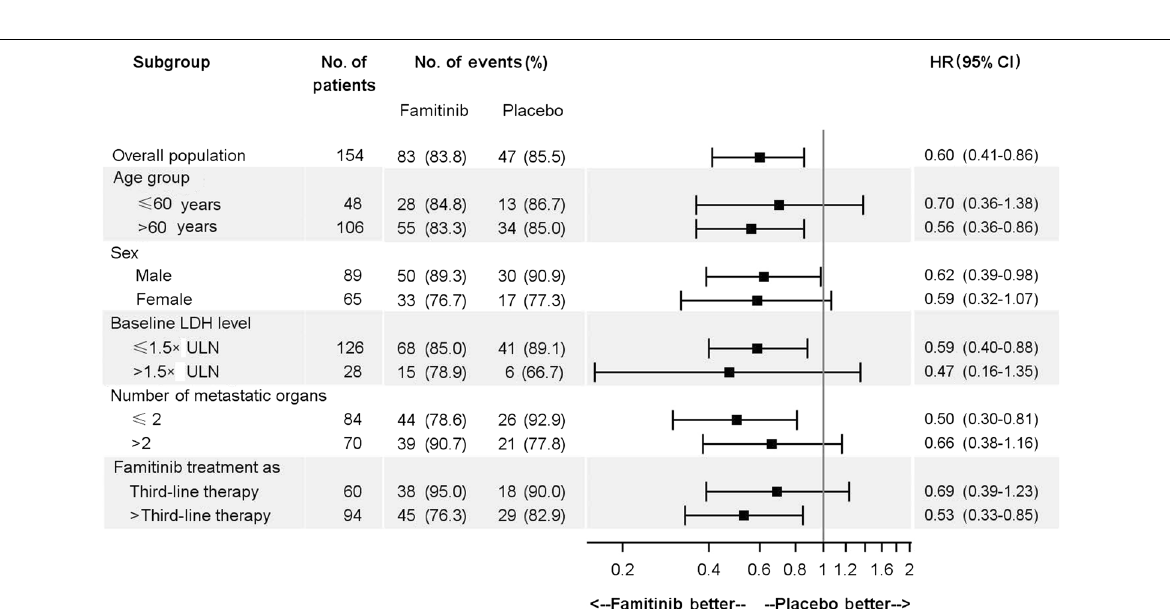
Fig. 3 Factors associated with PFS of mCRC patients as identified by stratified analysis. LDH lactate dehydrogenase, ULN upper limit of normal, HR hazard ratio, 95% CI 95% confidence